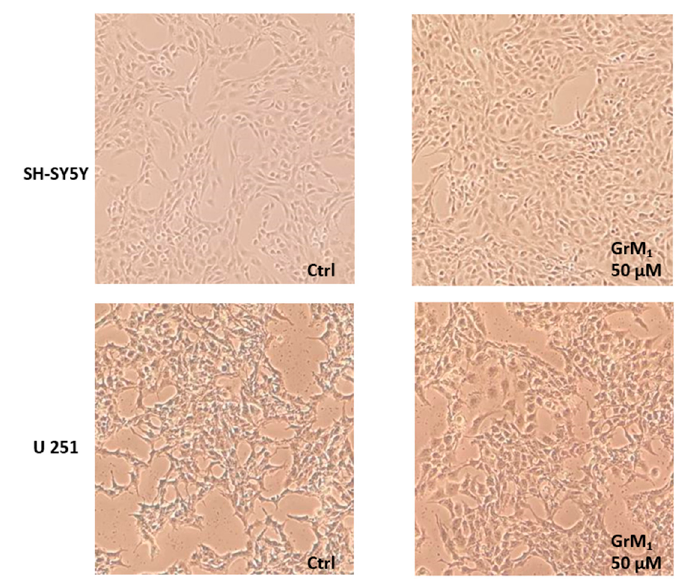
Figure 11. Morphological analysis of cells treated with GrM 1 pure compound after 48 h exposure time.